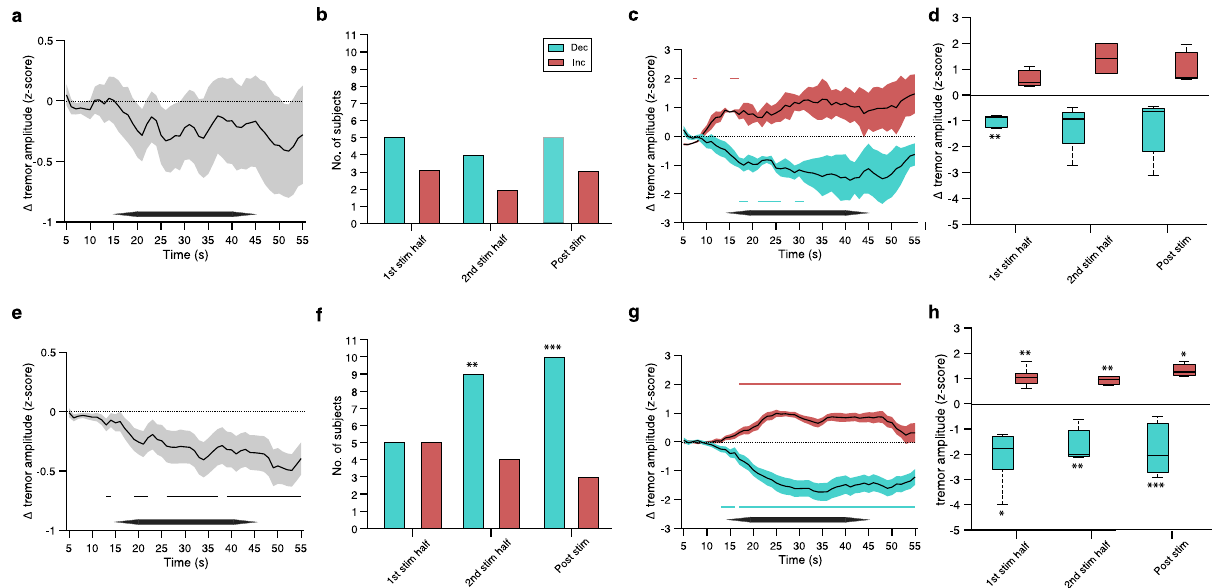
Fig. 3 Characterisation of change in tremor amplitude induced by stimulation. a – d Stimulating currents were applied at the tremor frequency but without phase-locking. a Change in tremor amplitude over time, shown are mean ± s.e.m. z -score computed using 10 s window every 1 s between 5 s and 55 s; horizontal black bar outlines stimulation period. b Number of participants with signi fi cant reduction (turquoise bars) and increase (red bars) in tremor amplitude during the fi rst-half of stimulation period ( ‘ 1st stim half ’ ), second half of stimulation period ( ‘ 2nd stim half ’ ), and post-stimulation period ( ‘ post stim ’ ); see Supplementary Table 4. c Change in tremor amplitude over time across participants with signi fi cant reduction (turquoise) and increase (red) in tremor amplitude during 2nd stim half in ( b ), shown are mean ± s.e.m. z -score; horizontal turquoise and red lines show corresponding epochs with signi fi cant z -score amplitude; horizontal black bar outlines stimulation period. d Change in tremor amplitude across the participants with signi fi cant reduction (turquoise) and increase (red) in tremor amplitude in ( b ), box plot shows 25 and 75% percentile values; horizontal red line, median value; horizontal black lines, data range, throughout the fi gure; from left-to-right n = 5,3,4,2,5,3 participants. e – l Stimulating currents were phase-locked to the tremor movement. e Change in tremor amplitude over time, showing the same as in ( a ); horizontal black lines show epochs with signi fi cant z -score amplitude. f Number of participants with statistically signi fi cant reduction and increase in tremor amplitude in ( e ), showing the same as in ( b ); *, from left- to-right p = 0.0019, p = 3.4 ⋅ 10 − 5 . g Change in tremor amplitude over time across participants with decreased and increased tremor amplitude during 2nd stim half in ( f ), showing the same as ( c ). h Change in tremor amplitude in ( f ), showing the same as in ( d ); from left-to-right n = 5,5,9,4,10,3 participants. Signi fi cance of z -score amplitude was analysed using unpaired two-sided t -test; Signi fi cance of number of participants was analysed using two-sided Fisher exact test against the number of participants who did not show a signi fi cant change; * indicates p < 0.05, ** p < 0.005, *** p < 0.0005, n.s. non-signi fi cant throughout the fi gure. Source data are provided as a Source Data fi